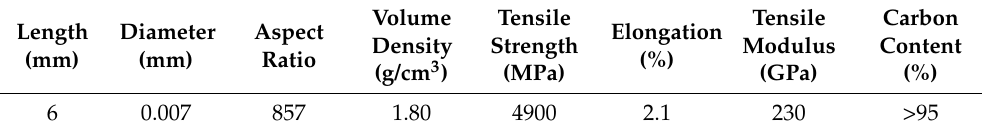
Table 2. Variation of mix design.